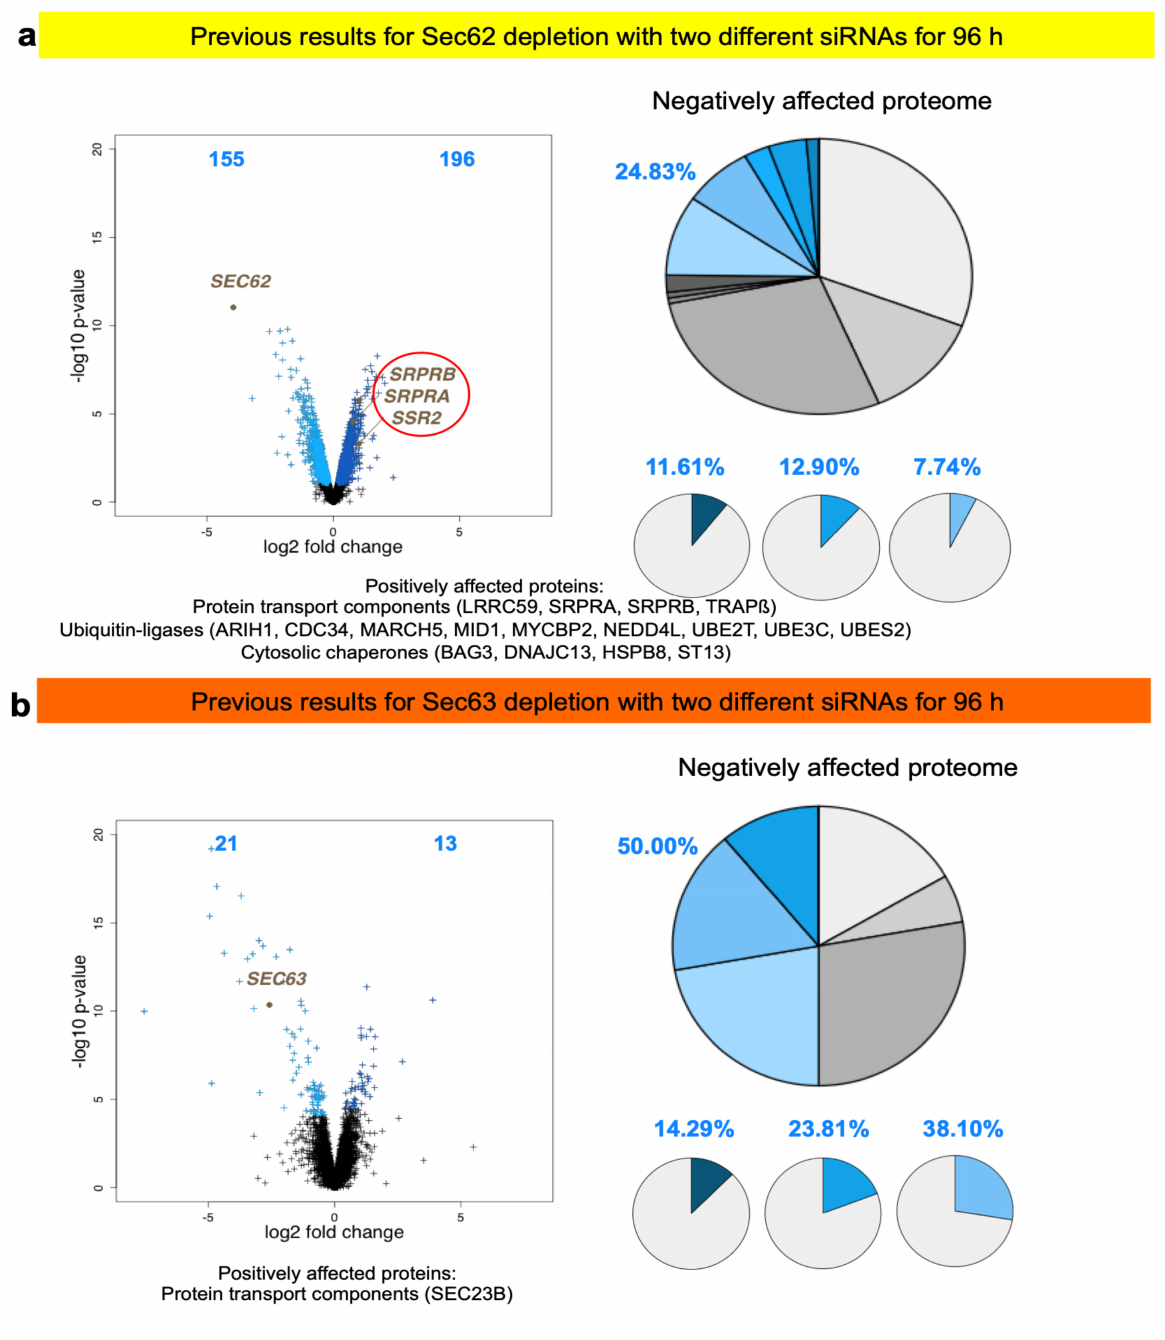
Figure 9. Representative volcano plots and GO enrichment after Sec62 and Sec63 depletion, respectively. Differentially affected proteins were characterized by the mean difference of their intensities plotted against the respective permutation false discovery rate-adjusted p -values in volcano plots. The representative results for a single targeting siRNA are shown on the left. SEC62 ( a ) and SEC63 ( b ), SSR2 , which codes for TRAPß, and subunits of the SRP receptor are highlighted in the plot after Sec62 depletion. In addition, the numbers of proteins, which were negatively or positively affected in both experiments, are given; the full set of relevant positively affected proteins are given below. Classification of the respective clients was based on GO enrichment factors where the results from the complete set of quantified proteins (not shown) are compared with the negatively affected proteome. Protein annotations of signal peptides, membrane location, and N-glycosylation in humans were extracted from UniProtKB, and used to determine the enrichment of GO annotations among the negatively affected proteins. The figure summarizes results from previous experiments and is shown here in modified form for comparison